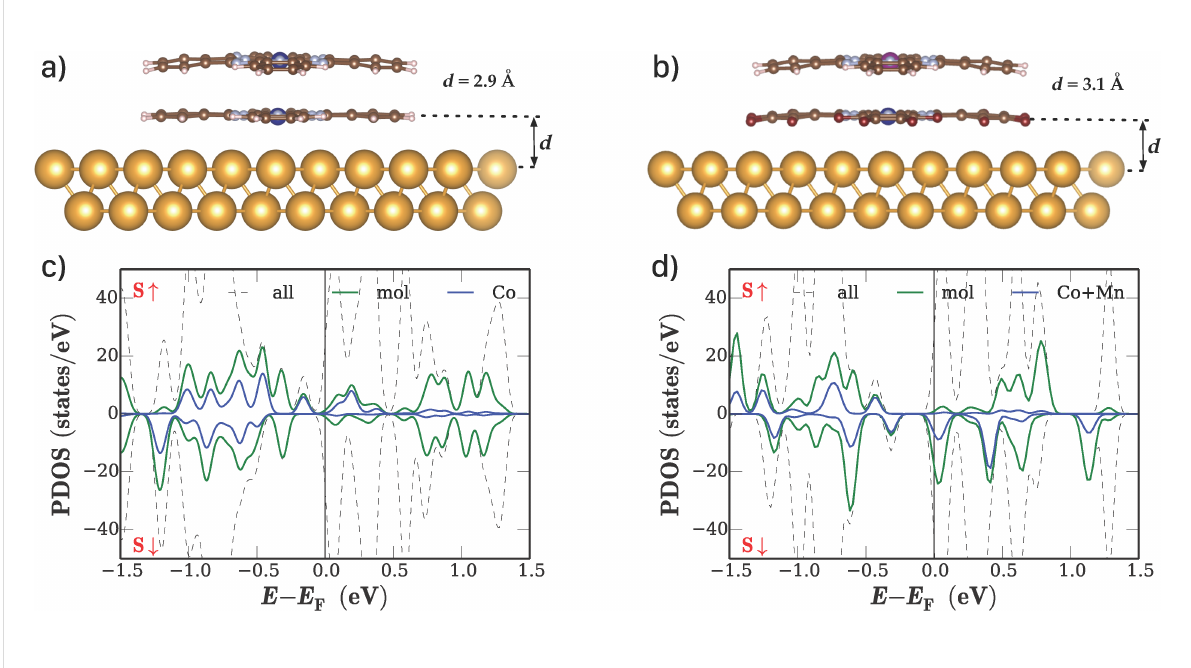
Figure 1: Results of DFT calculations for phthalocyanine stacks on fcc-Au(111) surfaces: relaxed geometries of a) the CoPc/CoPc stack and b) the F 16 CoPc/MnPc stack. c), d) Density of states (DOS) of the molecule-Au(111) interfaces as obtained from the calculations. The overall DOS as well as the projections onto the molecule and metal centers are